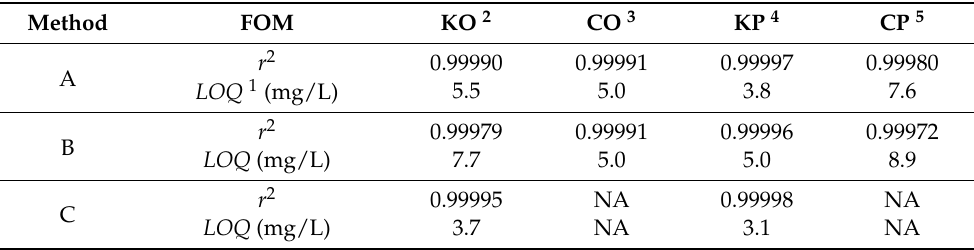
Table 1. Figures of merits (FOM) of the calibration curves using (A) itMPF with fminsearch used as optimization algorithms, (B) itMPF with fminnunc used as optimization algorithms, (C) classical approach with detection at 290 ± 4 nm. Standards were made by mixing the four diterpenes at different concentrations.